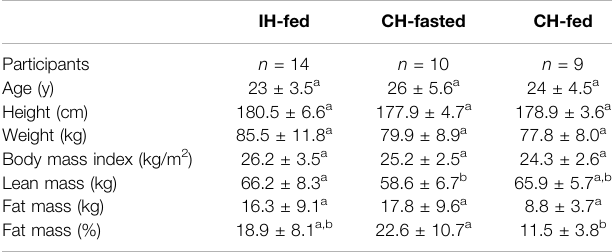
TABLE 1 | Characteristics of participants in the intermittent hypoxia (IH-Fed) and continuous hypoxia (CH-Fasted and CH-Fed) studies. IH-fed CH-fasted